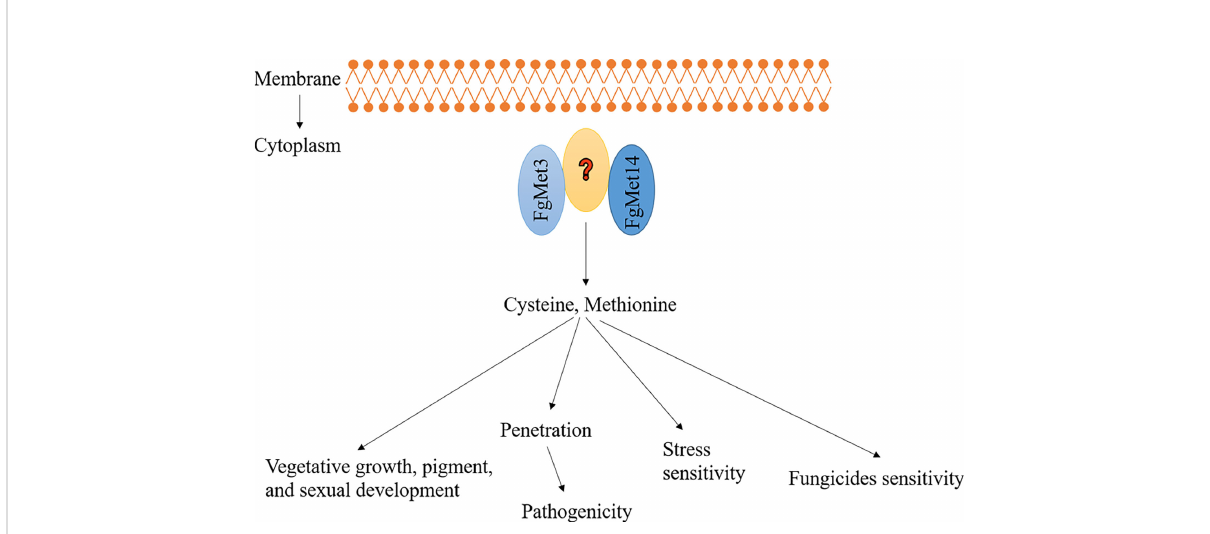
FIGURE 12 A proposed model showing the function of FgMet3 and FgMet14. FgMet3 interacts with FgMet14 indirectly, and they regulate development, pathogenicity, pigment formation, sensitivity to fungicides and stress factors of F. graminearum